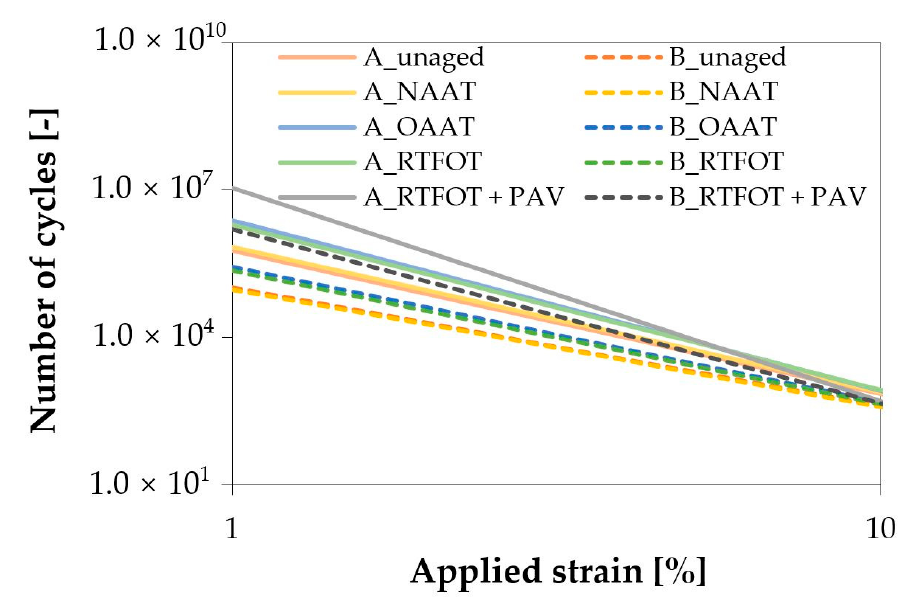
Figure 7. Fatigue life of binders A and B (at different aging conditions).